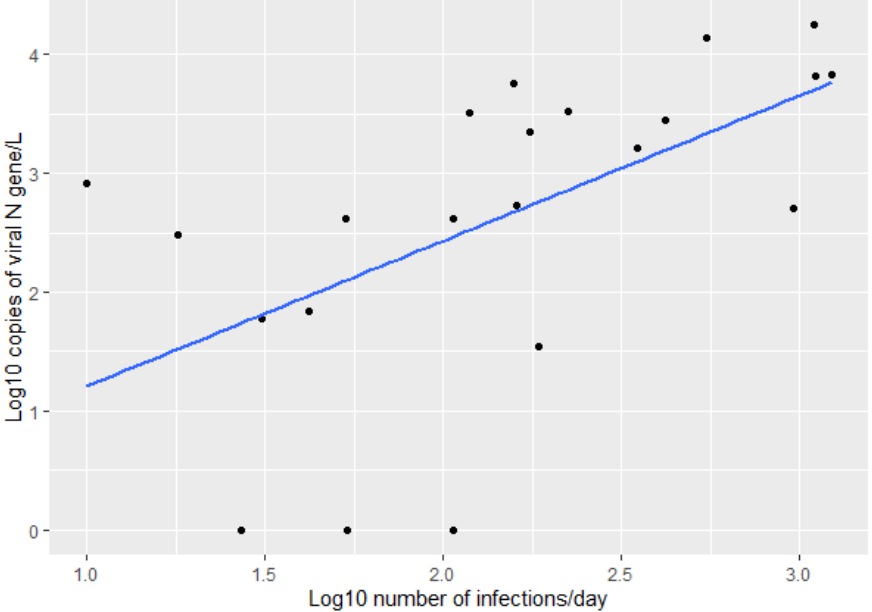
Figure 2. Correlation between the log10 transformed number of infections on the day of sampling and the log10 amount of virus detected in WWTP influent (Pearson correlation = 0.569).